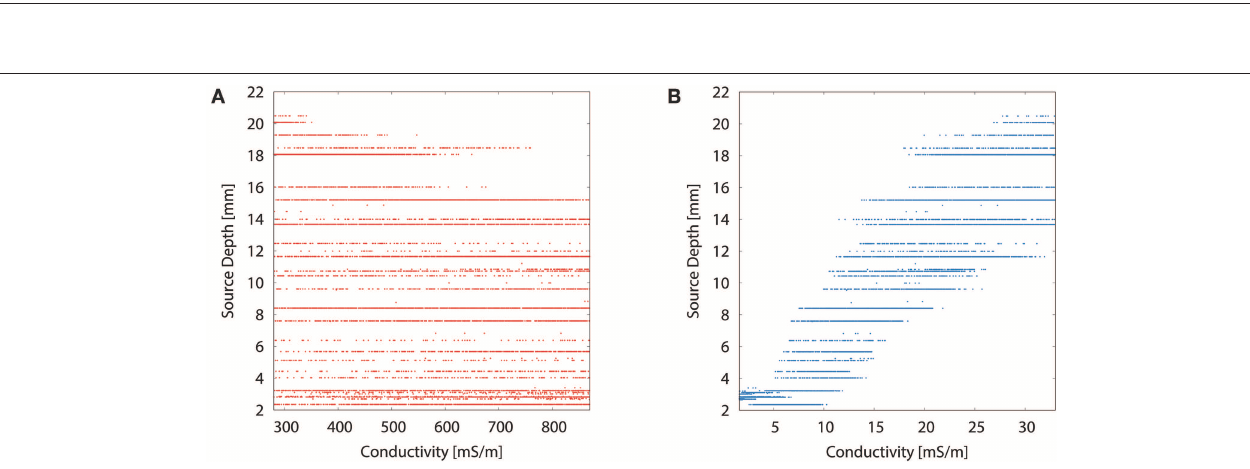
FIGURE 7 | Scatter plots of source depth (A) and GoF (B) for GFS with free location and orientation as a function of the tissue conductivity for univariate distributions. Conductivities are normalized to the interval from 0 to 1 for clarity of the visualization. Plots for CSF and gray matter are slightly shifted in positive and negative y-direction, respectively, since sources for CSF, gray matter, and partially white matter are localized at the same depth.